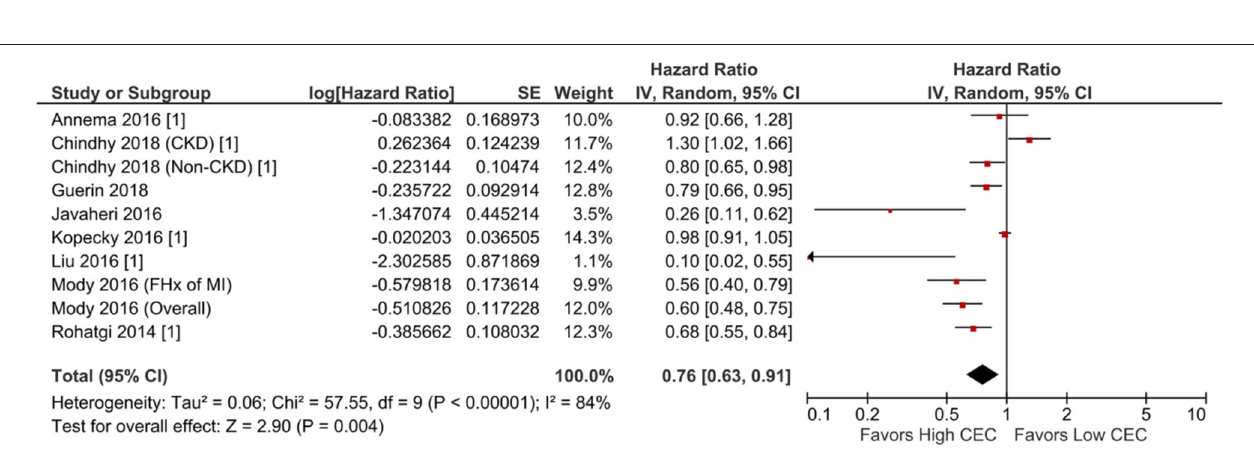
with a 34% lower risk of ASCVD (RR = 0.66;